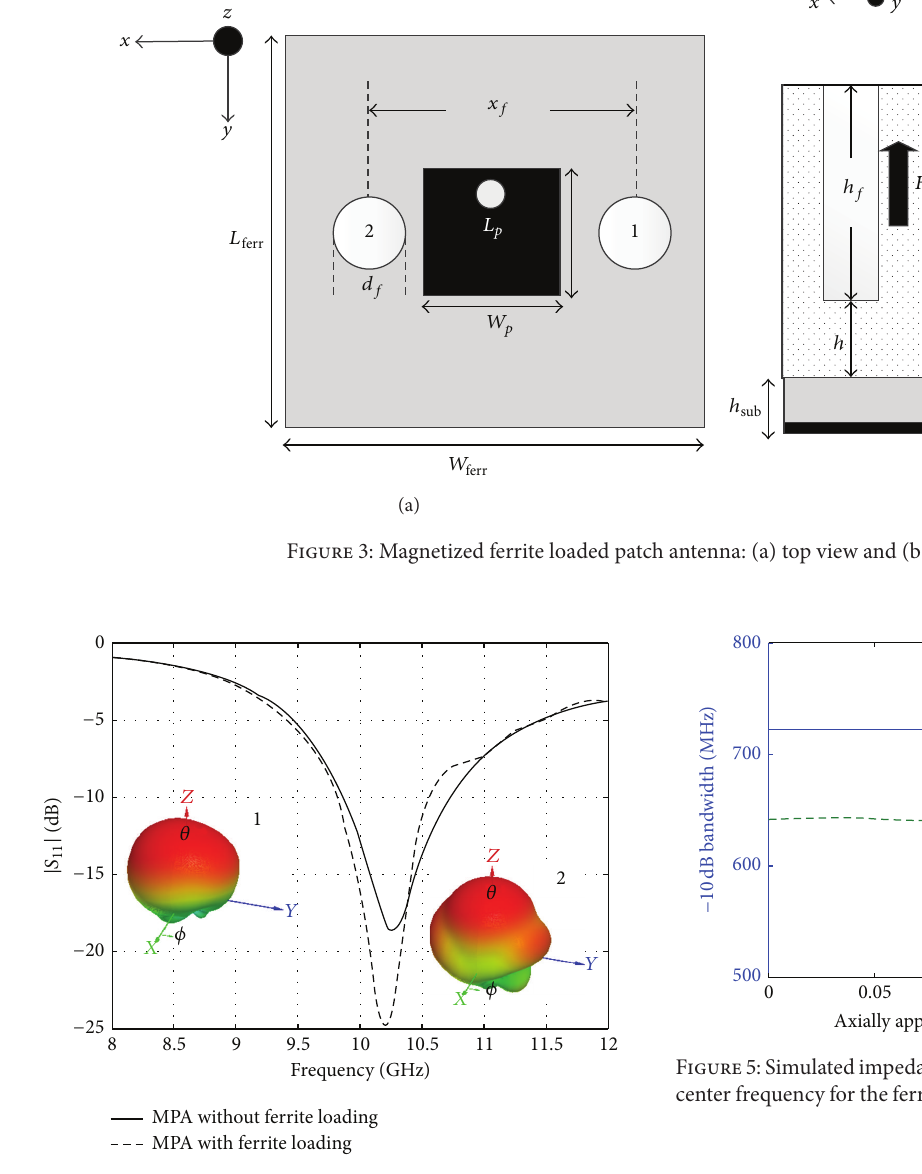
Figure 4: Simulated 𝑆 11 curves for the MPA with and without the ferrite superstrate.